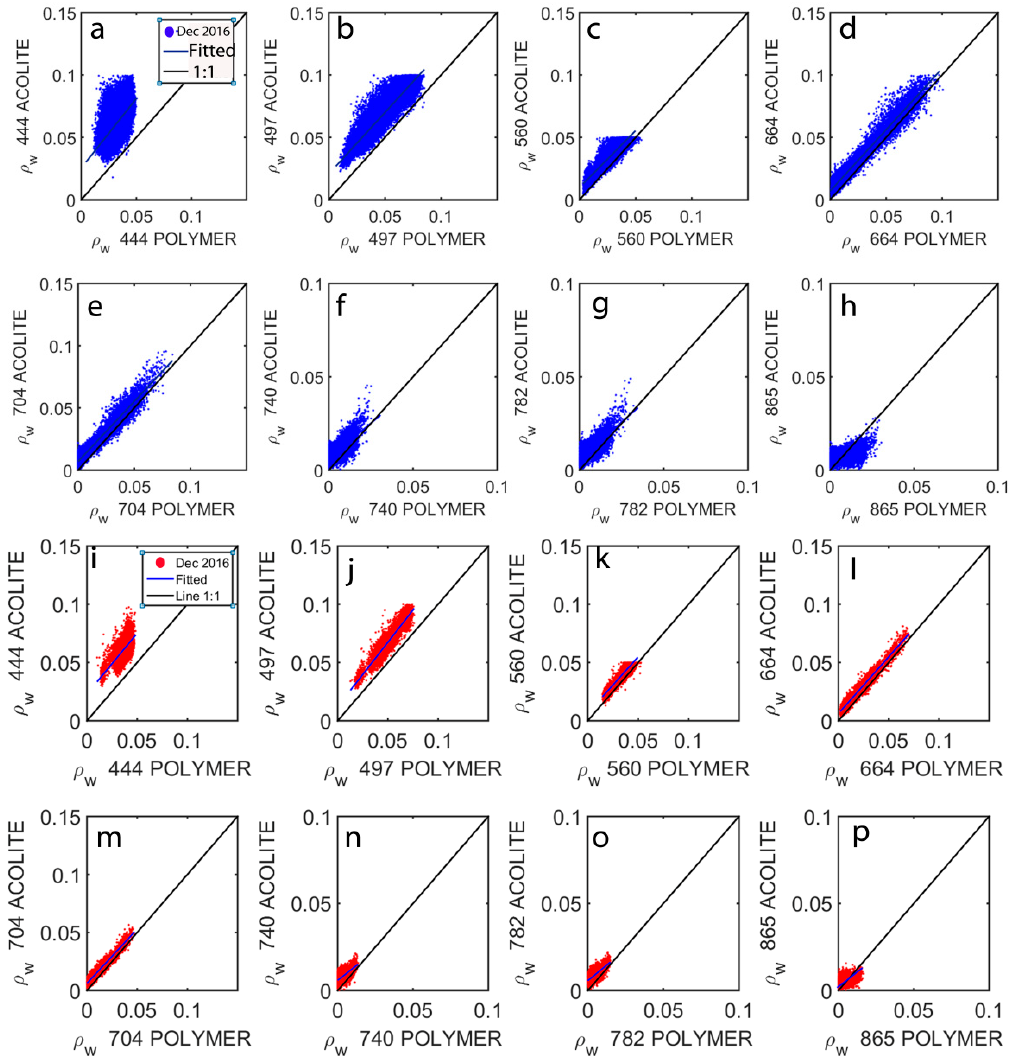
Figure 9. Scatter plots showing the comparison between water reflectance ( ρ w) derived from the 13 December 2016 image over the Andalusian coastal waters within the Guadalquivir ( a – h ) and Cadiz Region of Interest (ROI) ( i – p ) with POLYMER and ACOLITE for the visible (B1–B7, 444–783 nm) and near-infrared (NIR) bands (B8, 865 nm). The blue line is the fitted line. The dashed black line is the 1:1 line.